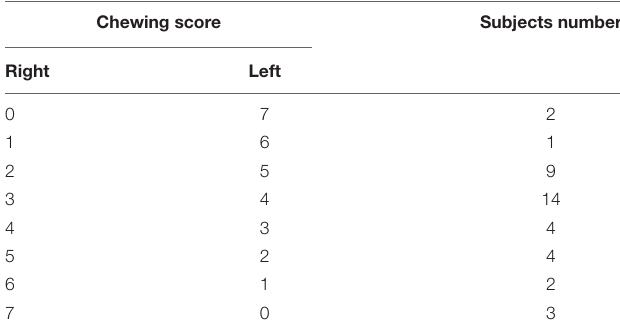
TABLE 2 | Distribution of the number of subjects for the chewing side preference score. Chewing score